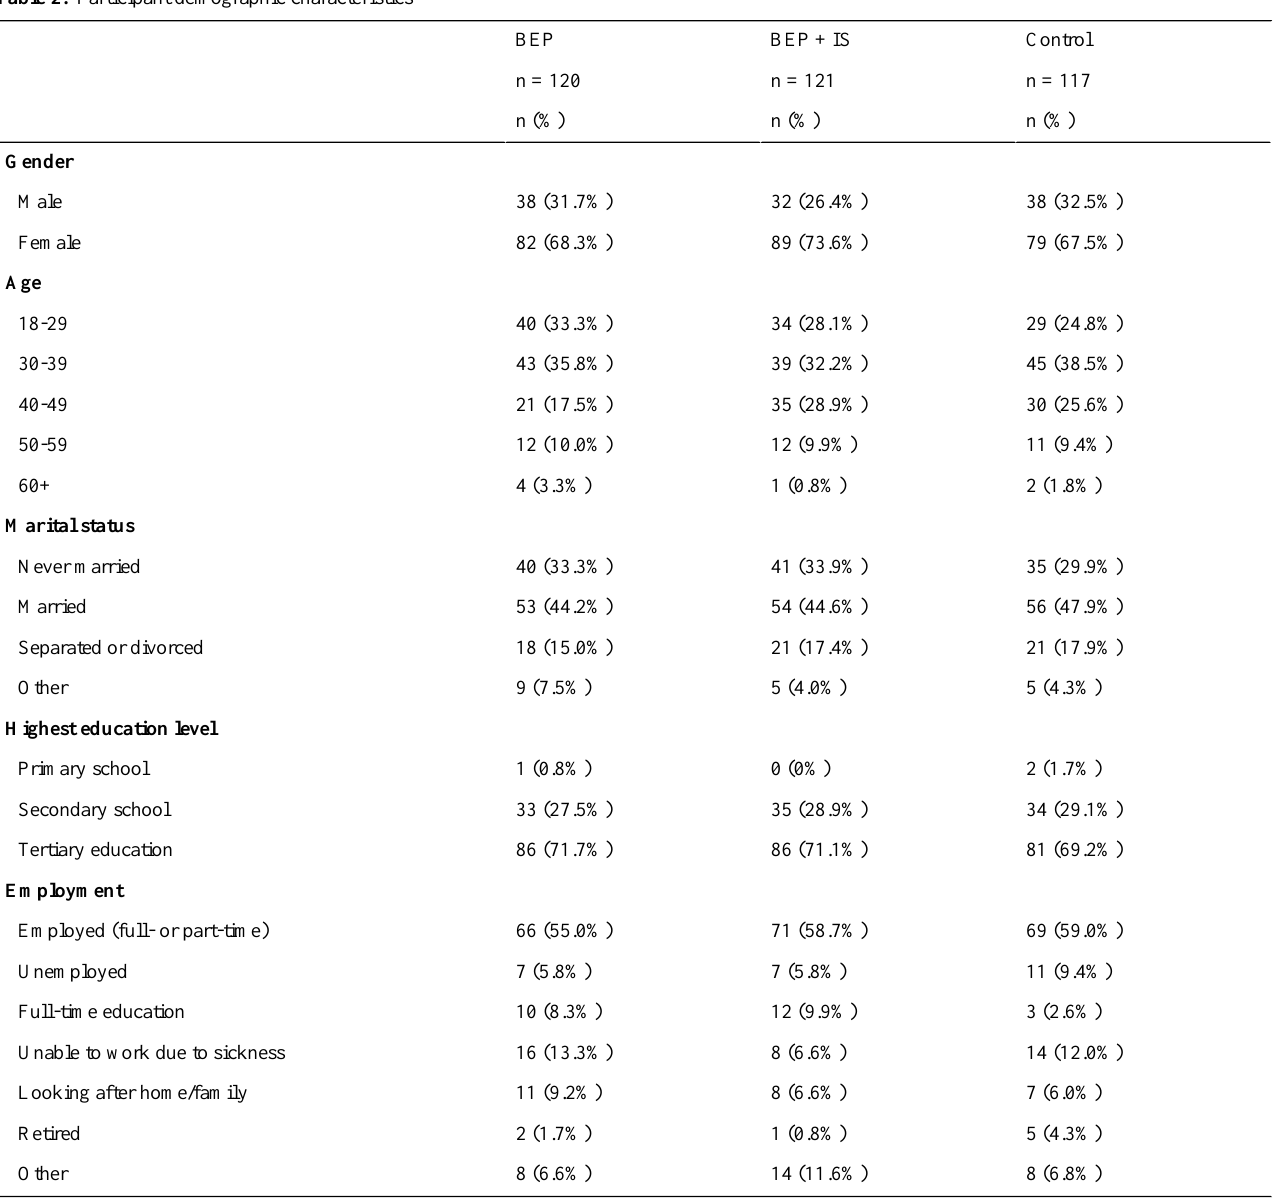
Table 2. Participant demographic characteristics